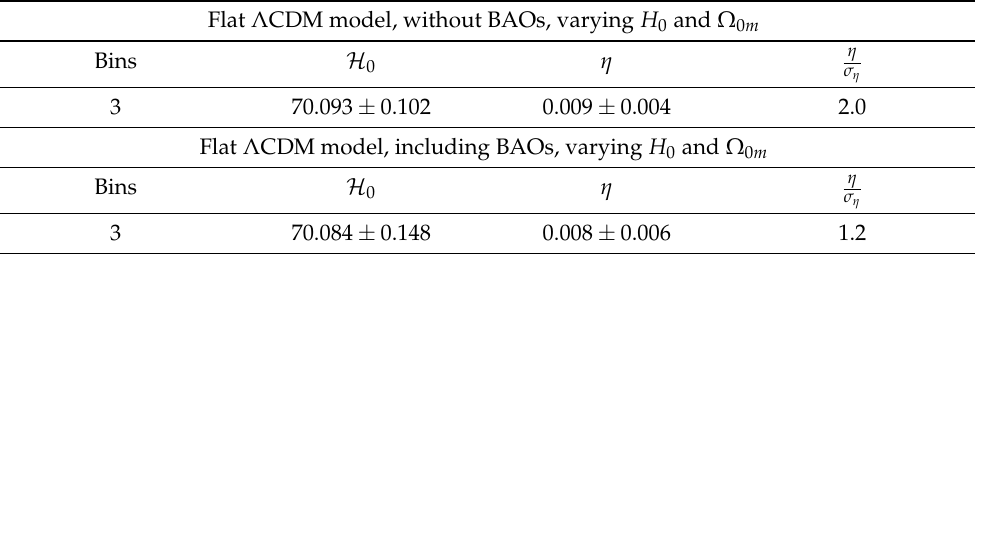
Table 1. Upper half. Fit parameters of H 0 ( z ) for three bins (flat Λ CDM model, varying H 0 and Ω 0 m ) in the cases with SNe only and with the SNe + BAOs contribution. The columns are: (1) the number of bins; (2) H 0 , (3) η ; (4) how many σ s the evolutionary parameter η is compatible with zero (namely, η / σ η ). Lower half. Similarly to the upper half, the lower half shows the fit parameters of H 0 ( z ) (flat w 0 w a CDM model, varying H 0 and w a ) without and with the